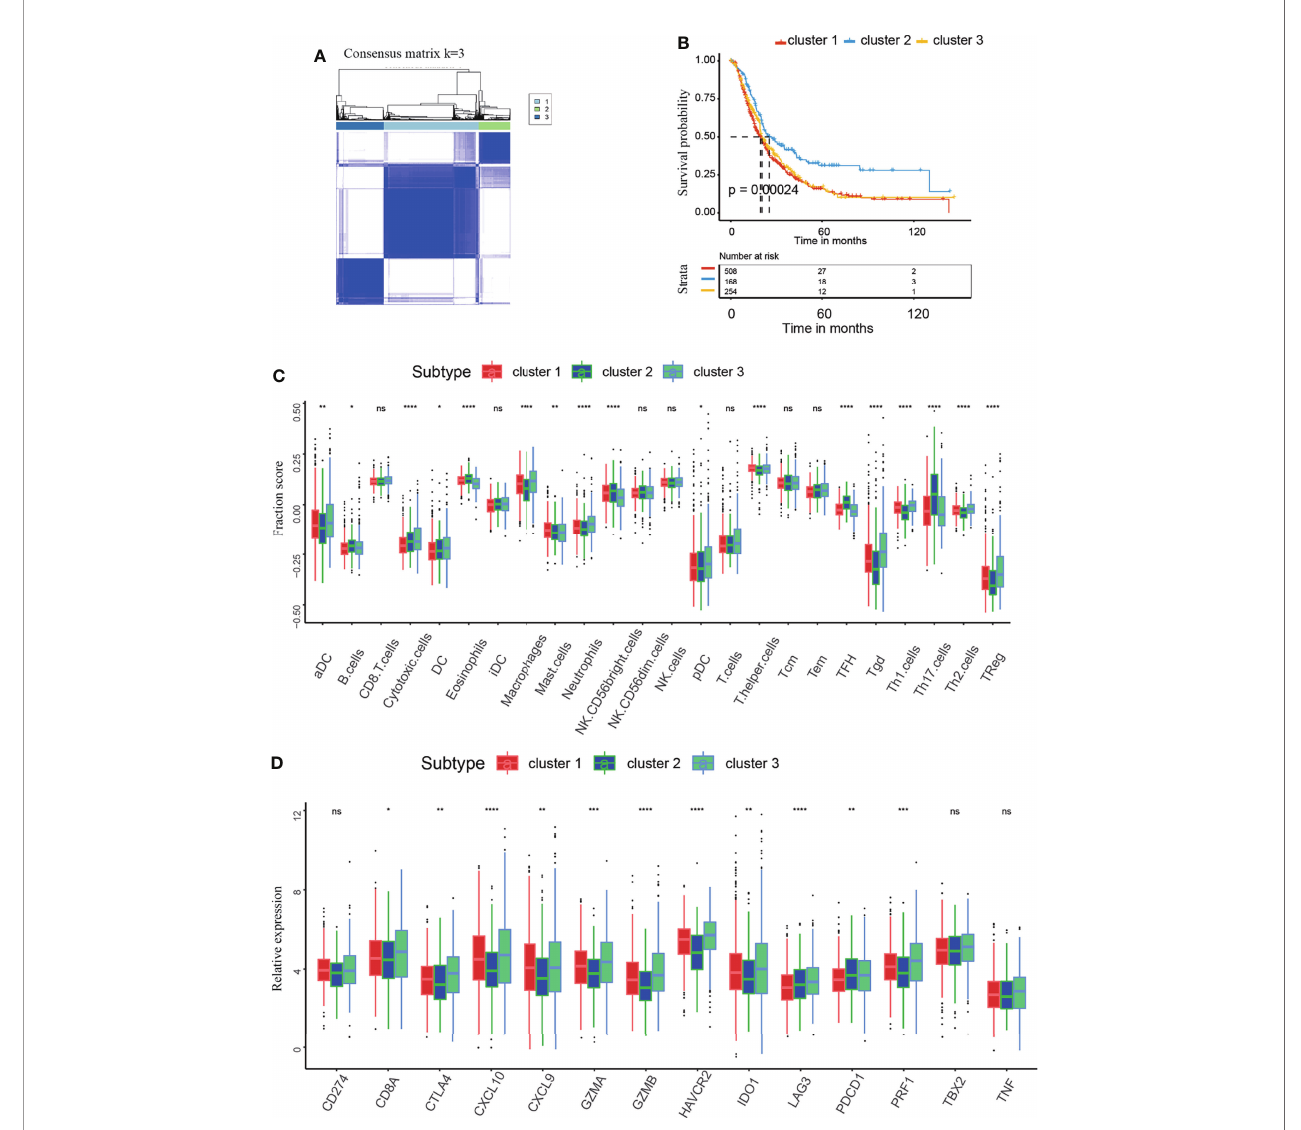
FIGURE 3 | Identi fi cation of the consensus clusters and analysis of the correlation between clusters and the immune microenvironment. (A) Consensus clustering matrix for k=3. (B) Kaplan – Meier curves of overall survival (OS) in m 5 C clusters 1-3 of patients with PAAD. (C) Immune cell in fi ltration in m 5 C clusters 1-3. (D) Expression levels of immune activation-related genes and immune checkpoint-related genes in m 5 C clusters 1-3. * represents p value < 0.05, ** represents p value < 0.01, *** represents p value < 0.001, **** represents p value < 0.0001, ns means "not statistically signi fi